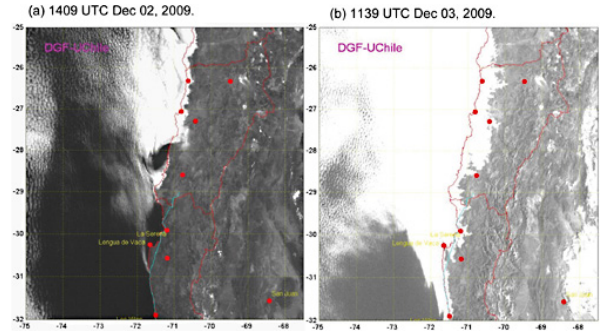
Fig. 11. GOES-13 visible images over the CUpEx area for (a) 14:09UTC 2 December 2009, and (b) 11:39UTC 3 Decem- ber